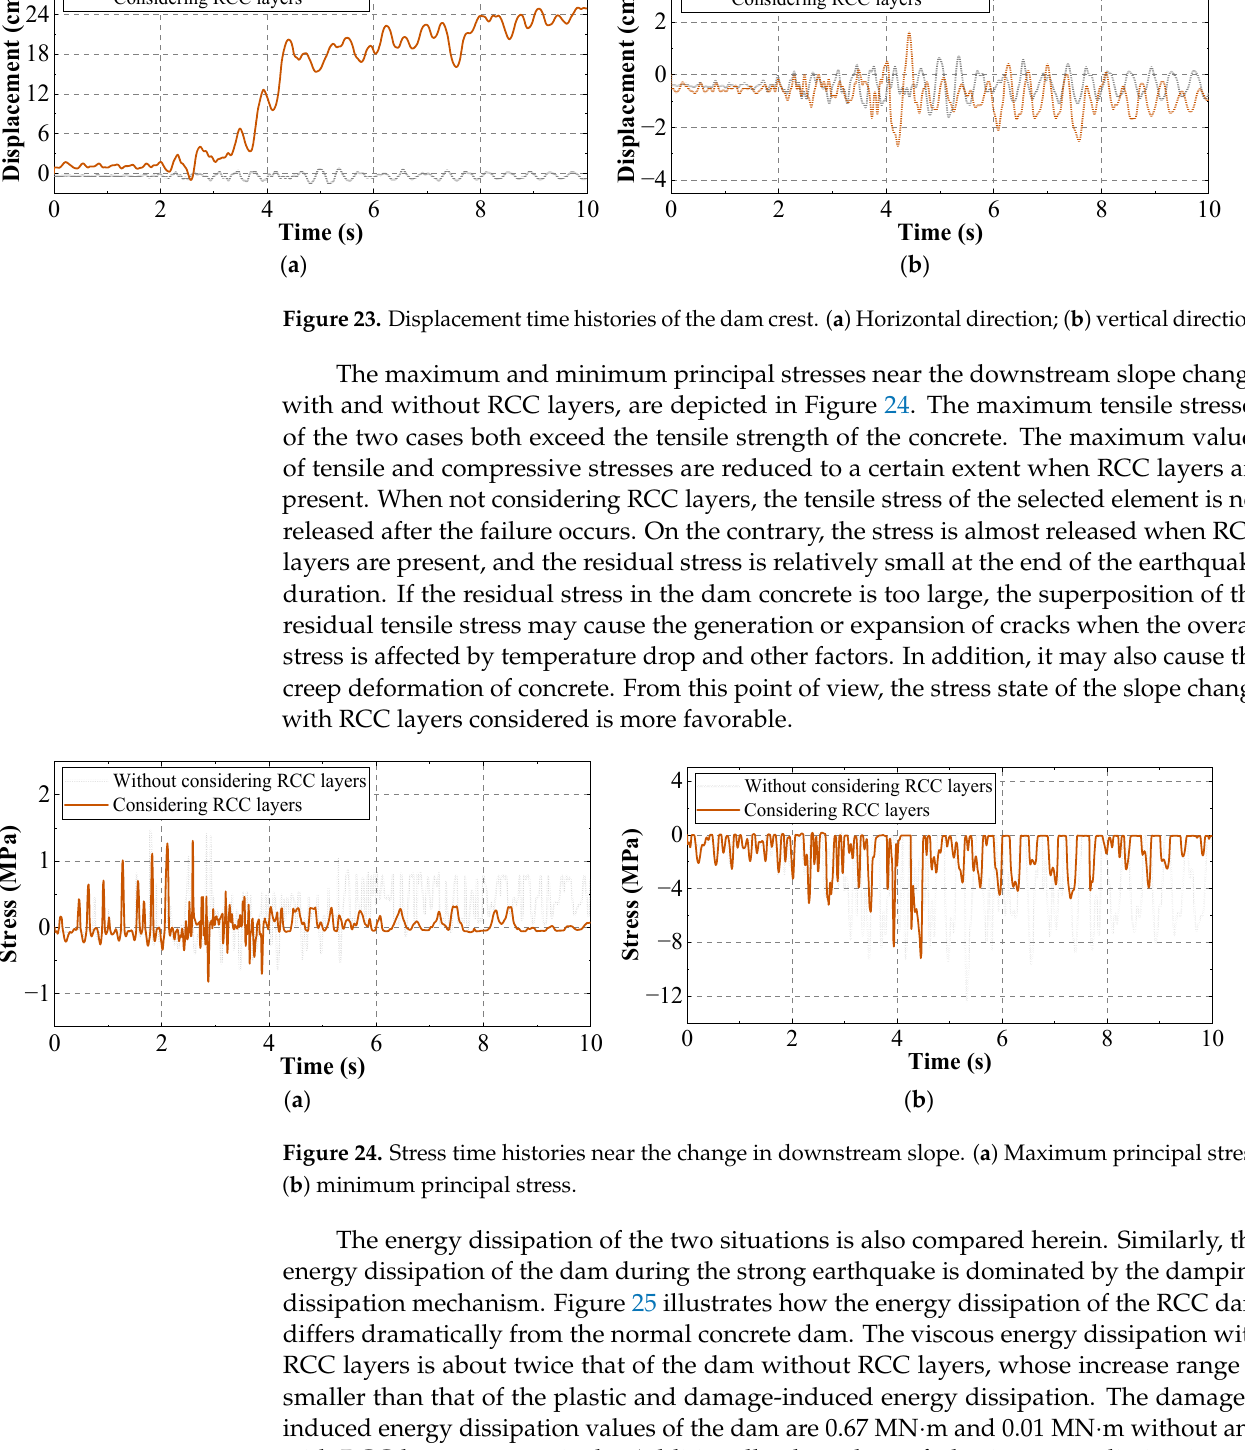
( c ) Figure 25. Comparison of the energy dissipation. ( a ) Damage energy dissipation; ( b ) plastic energy dissipation; ( c ) viscous energy dissipation. 6.3. Damage Propagation Analysis Figures 26 and 27 depict the damage evolution process of the dam when RCC layers are present and the ultimate damage profiles of the dam. The results illustrate that the RCC layers have an obvious effect on the failure characteristics of the dam. When the RCC layers are taken into consideration, tensile damage first occurs at the downstream slope change due to the stress concentration. Then the interlayer between the two materials C15 and C20 begins to sustain damage. Because of the interaction of the adjacent RCC layers, the damage gradually expands to the adjacent layer. Finally, a small area of the upper part of the downstream face is damaged.